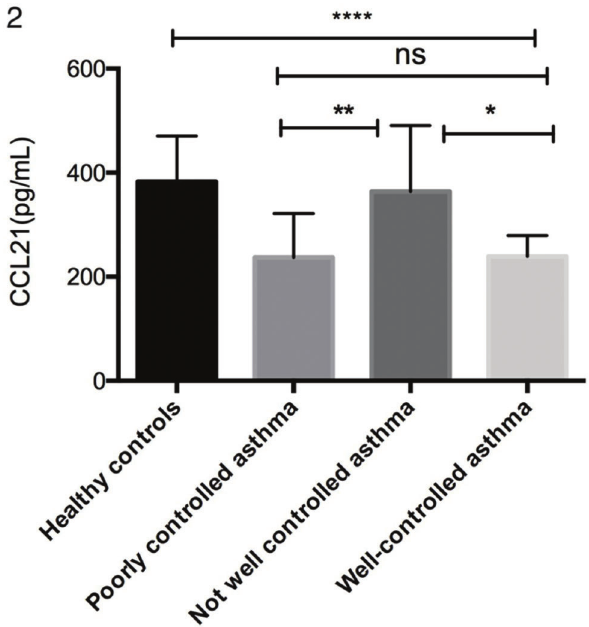
Figure 2 - Comparison of serum CCL21 levels in different asthma control subgroups. Serum CCL21 levels were determined by ELISA. Statistical analysis was performed by one-way ANOVA. * p o 0.05, ** p o 0.01, **** p o 0.0001. ANOVA, analysis of var- iance; ELISA, enzyme-linked immunosorbent assay; CCL, chemo- kine